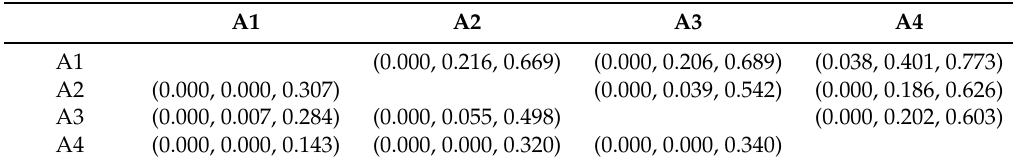
Table 13. The preference index of the four alternatives.